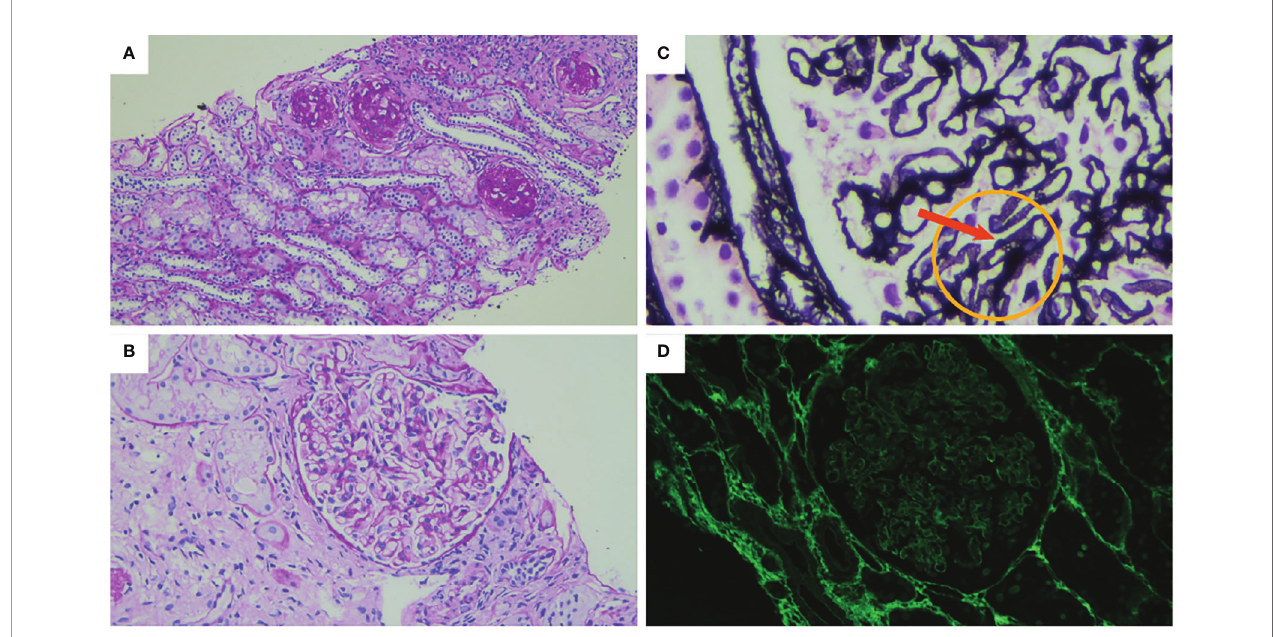
FIGURE 2 | The result of the renal biopsy shows (A) diffuse global glomerulosclerosis. Periodic acid Schiff (PAS) stain original magni fi cation: ×100. (B) Glomerular basal membrane (GBM) thickening. PAS stain original magni fi cation: ×400. (C) Prominent vacuolated appearance of GBM indicated by the arrow. Jones methenamine silver, original magni fi cation: ×1,000. (D) No PLA2R immune deposits (immuno fl uorescence, original magni fi cation: